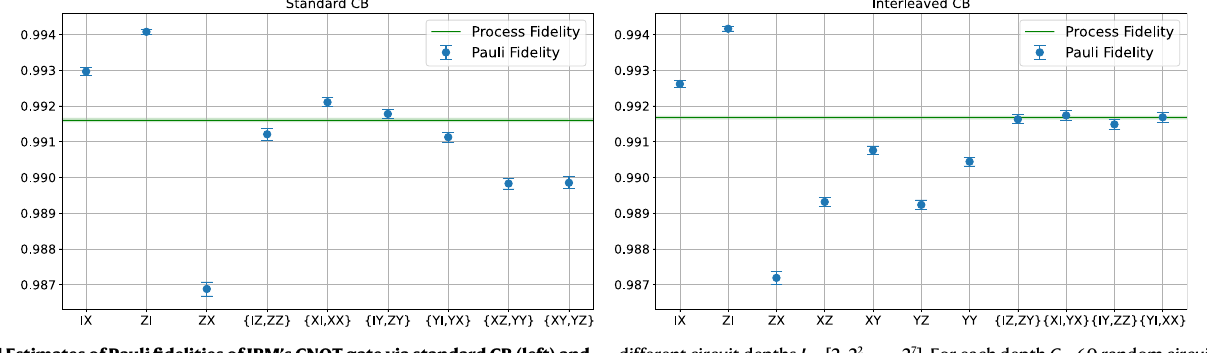
differentcircuitdepths L =[2,2 2 ,...,2 7 ].Foreachdepth C =60randomcircuitsand 1000 shots of measurements are used. Throughout this paper, the error bar represents the standard